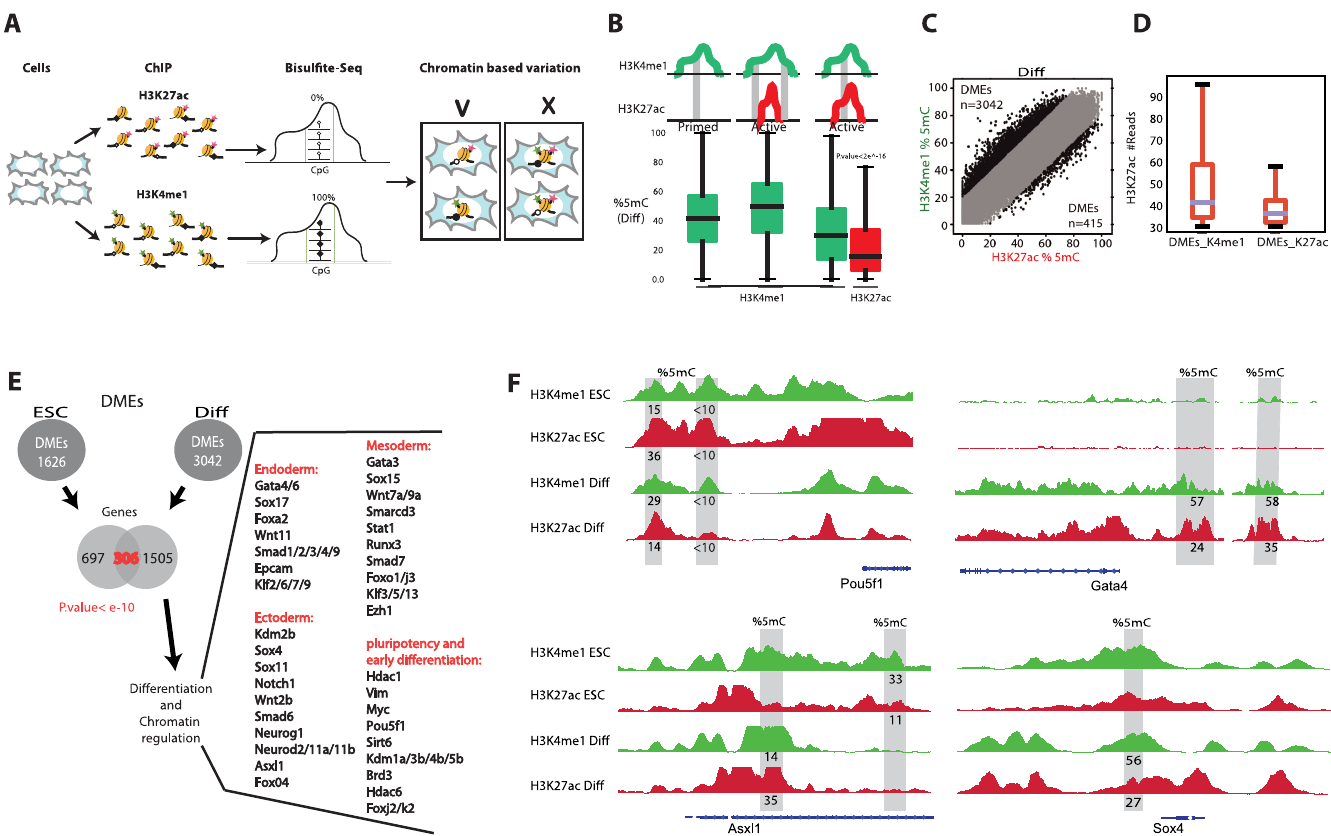
Fig 3. DNA methylation states of distal enhancers support chromatin-based cellular heterogeneity. (A) Schematic representation of ChIP-BS-seq for H3K4me1 and H3K27ac histone marks emphasizing that different 5mC levels are explained only by chromatin-based heterogeneity. (B) Locations of 5mC in the three most frequent scenarios (schematics above the boxplots). Boxplots show 5mC percentages in each chromatin state. (C) Plot of 5mC percentages in H3K4me1 and H3K27ac genomic segments in differentiated cells. Only genomic bins with more than 30 CpGs in both ChIP-BS-seq assays are shown. DMEs were defined as 200-bp bins with methylation differences exceeding 20%. (D) H3K27ac read counts within DMEs bound by H3K4me1 (left) and H3K27ac (right). (E) Genes with DMEs annotated based on the mouse cis -regulatory atlas [38]. The Venn diagram shows a significant overlap of 306 genes (Hypergeometric test, p < e -10 ) of genes regulated by DMEs in both undifferentiated and differentiated cells. Some of the overlapping genes are listed, grouped according to function. (F) IGV tracks of DMEs for Pou5f1 , Gata4 , Asxl1 , and Sox4 . Percentages of 5mC in the grey blocks are specified beneath each track. For adjacent DMEs, 5mC levels were averaged.